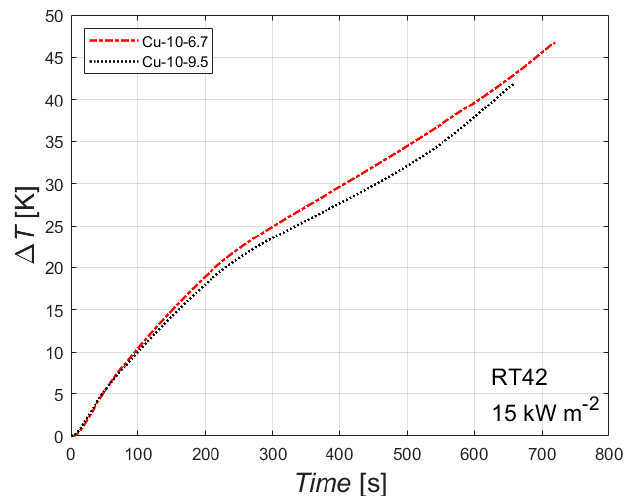
Figure 7. Effect of foam relative density, i.e., of porosity, on the difference between wall and initial temperatures for the paraffin RT42 with an imposed heat flux of 15 kW m − 2 for the two 10 PPI copper foams.